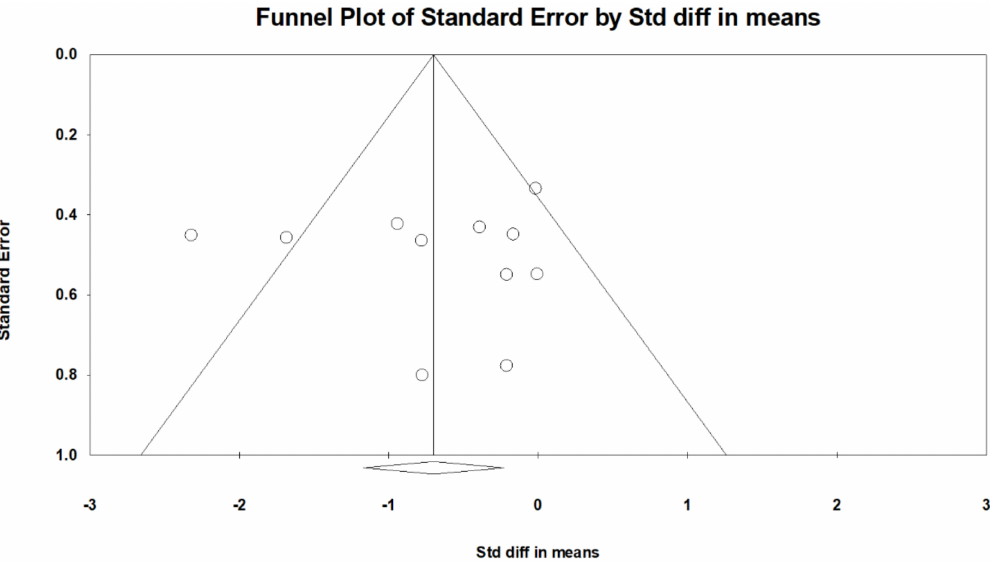
Figure 4. Funnel plot of standardized mean differences in Fibromyalgia Impact Questionnaire after treatment. Each dot indicates a single study, and the diamond indicates the summarized effect